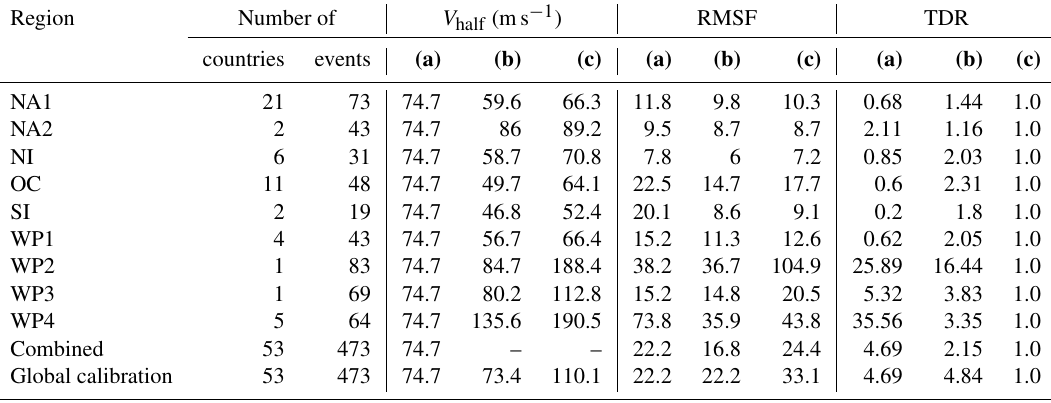
Table A2. Resulting impact function slope parameter V half and optimization metrics RMSF and TDR per region for (a) the global default impact function (uncalibrated), (b) calibrated by optimizing RMSF, and (c) calibrated by optimizing TDR. The regions NA1 to WP4 are defined in Table A1. The row “combined” summarizes results for all regions combined based on the regionalized calibration; the row “global calibration” is based on one unified global calibration based on all matched TC 473 events. RMSF: root-mean-squared fraction; TDR: total damage ratio.